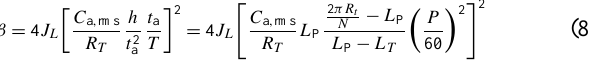
Figure 12. β surface as a function of tools number – bottom view.